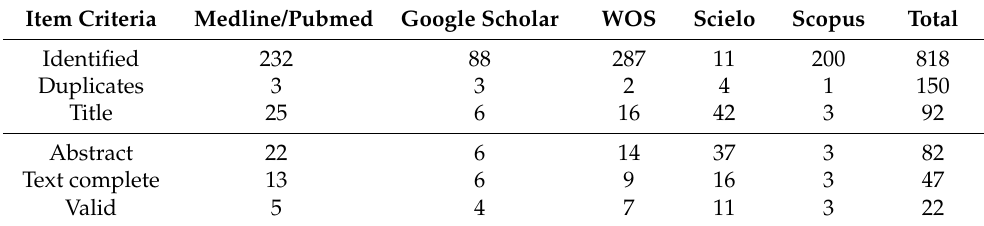
Table 1. Databases